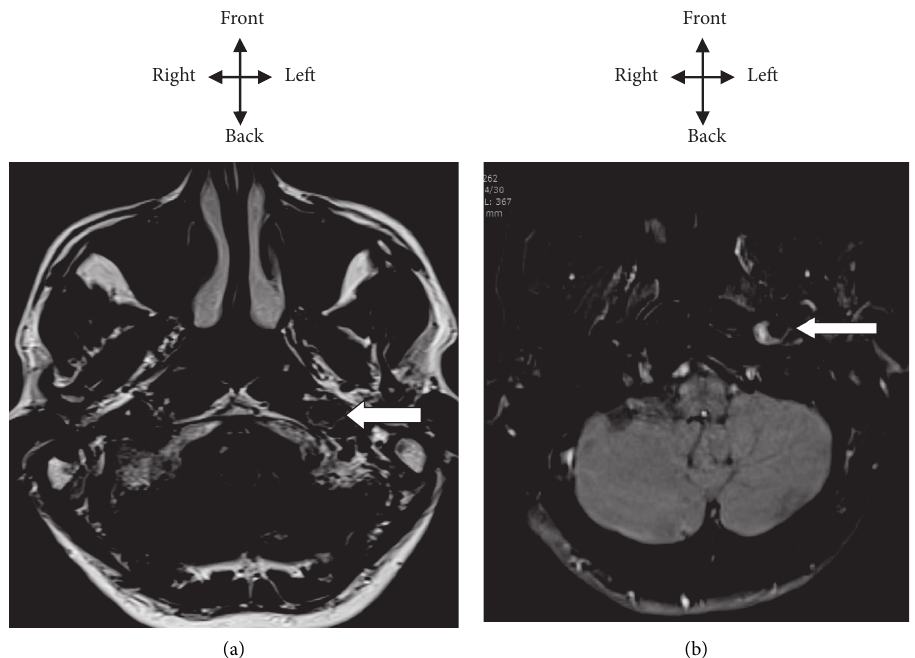
Figure 4: MRI of the neck vessels, T2 FLAIR axial (a) and T1 FAT-SAT axial (b), hyperintense subintimal